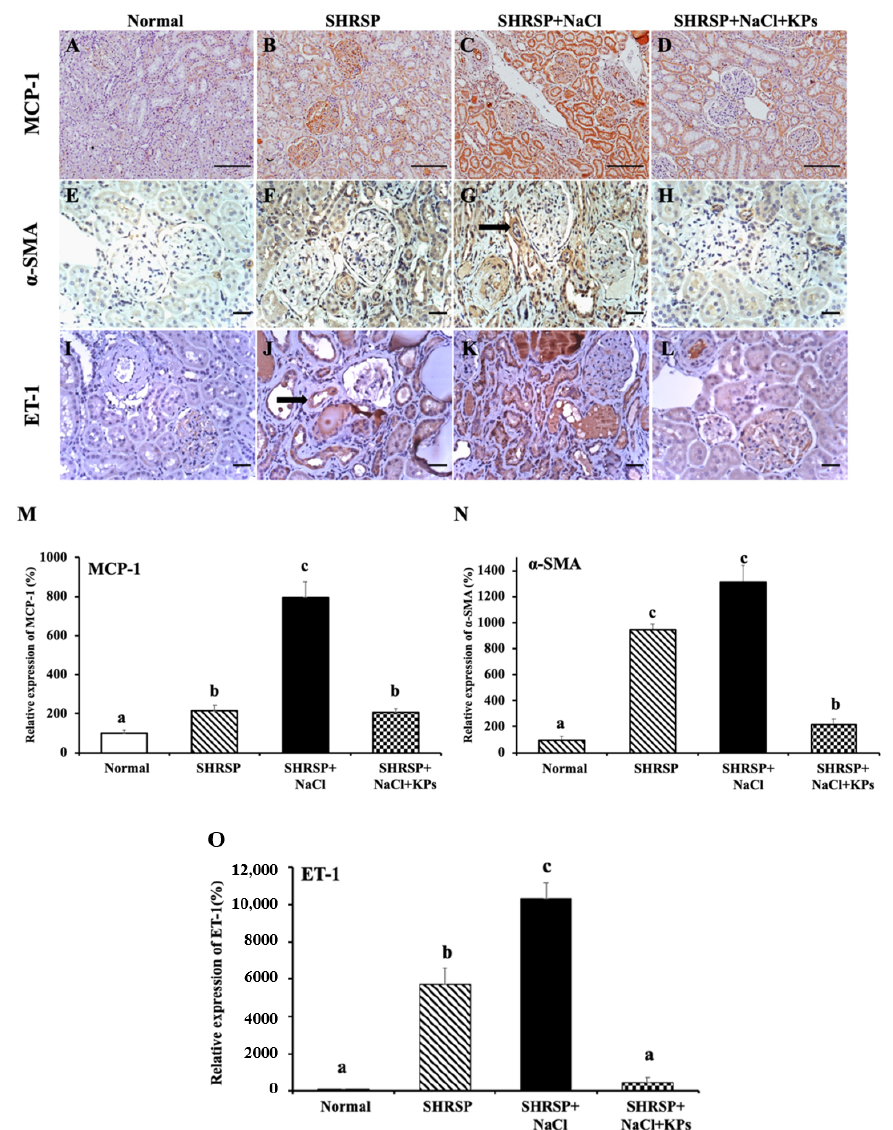
Figure 4. Effects of KPs on MCP-1, α -SMA, and ET-1 expression in the tubular cells and glomeruli of the kidneys of WKY and SHRSP rats, as determined by immunohistochemical (IHC) staining. The SHRSP + NaCl group ( C ) showed significantly more MCP-1 accumulation in tubular cells compared to WKY (normal) rats ( A ) and rats in the SHRSP group ( B ). The high MCP-1 expression in the SHRSP + NaCl group was reversed by the KPs treatment ( D ). Weak background staining for α -SMA was observed in the WKY (normal) rats ( E ). Positive IHC staining for α -SMA was noted in the smooth muscle of the venous neointimal tissue (black arrow) in the SHRSP + NaCl group ( G ), and more positive staining was observed in the SHRSP + NaCl group than in the SHRSP group ( F ). However, fewer α -SMA-positive renal cells were observed in the SHRSP + NaCl + KPs ( H ) group. Expressed E T-1 was concentrated in the cytoplasm of tubular epithelial cells (black arrow) in the SHRSP ( J ) and SHRSP + NaCl ( K ) groups. ET-1 expression was lower in the SHRSP + NaCl + KPs ( L ) group. ( A – D ) Images were observed under 200 × magnification; scale bar = 50 µ m. ( E – L ) Images were observed under 400 × magnification; scale bar = 20 µ m. Three fields were imaged for each individual. Quantitative analyses of the results of IHC staining for MCP-1 ( M ), α -SMA ( N ) and ET-1 ( O ) were carried out with ImageJ software. Data are presented as the means ± SEMs (Normal, n = 5; SHRSP, n = 5; SHRSP + NaCl, n = 6; SHRSP + NaCl + KPs, n = 6) and were analyzed by one-way ANOVA. Data within columns that are not labeled with the same letter are significantly different ( p < 0.05), as determined using Duncan’s